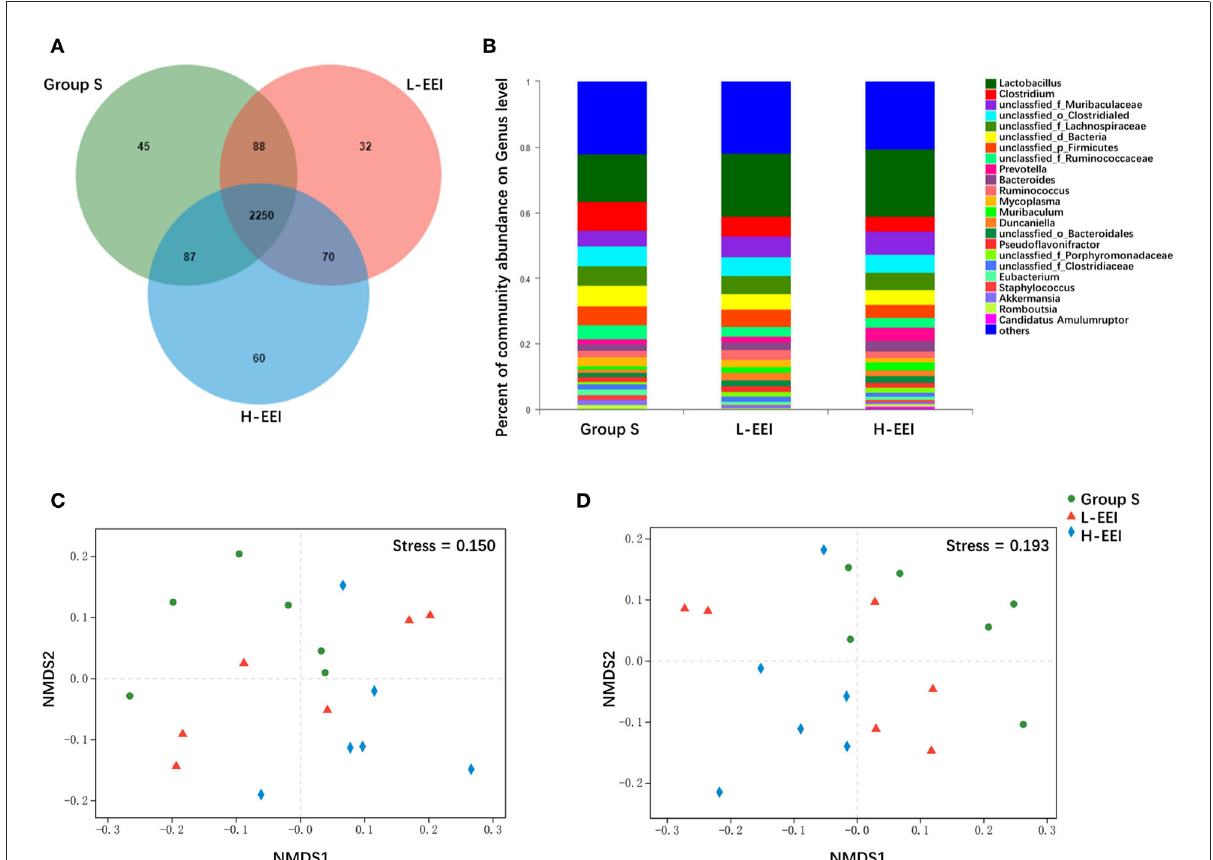
FIGURE1 H-EEI altered the β -diversity of fecal microbiota. (A) The Venn diagrams show that bacteria that are unique and shared by different groups at the genus level. The overlapping part represents the bacteria shared by different sample groups, the non-overlapping part represents the bacteria unique to the sample group, and the number represents the corresponding species. There were 45 and 32 genera specific to groups S and L-EEI, respectively, and 60 genera specific to H-EEI. (B) The relative abundance of the genus level in each group is shown. The horizontal axis represents the sample name, and the vertical axis represents the proportion of microbiota in the sample. Colored columns represent different microbiota, and column length represents a proportion of the microbiota. (C,D) The NMDS analysis of different groups shows a distinct formation of clusters at the genus level (C) , and according to species level (D) , Bray–Curtis. NMDS is a data analysis method that simplifies research objects in multidimensional space into low-dimensional space for positioning, analysis, and classification while retaining the original relationship between objects. The pros and cons of NMDS analysis results are measured by stress. It is generally believed that when stress < 0.2, it can be represented by a two-dimensional point graph of NMDS, and this graph has a certain explanatory significance. The distance between the points indicates the degree of difference, and the horizontal and vertical coordinates indicate the relative distance, which has no practical significance. The data used in the analysis were derived from metagenomics sequencing data of fecal mirobiota ( n = 6 in each